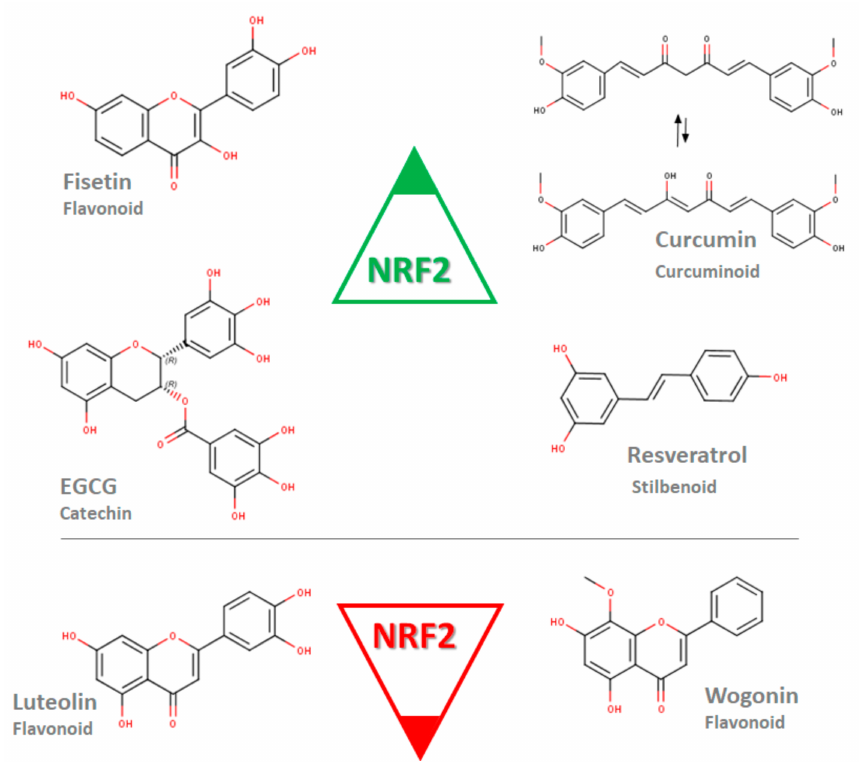
Figure 2. Polyphenols of various subgroups modulating the expression of NRF2 at the mRNA or/and protein level. Fisetin, epigallocatechin-3-gallate (EGCG), curcumin and resveratrol induce NRF2 in contrast to luteolin and wogonin (Marvin was used for drawing chemical structures, Marvin 20.20.0 (2020), ChemAxon